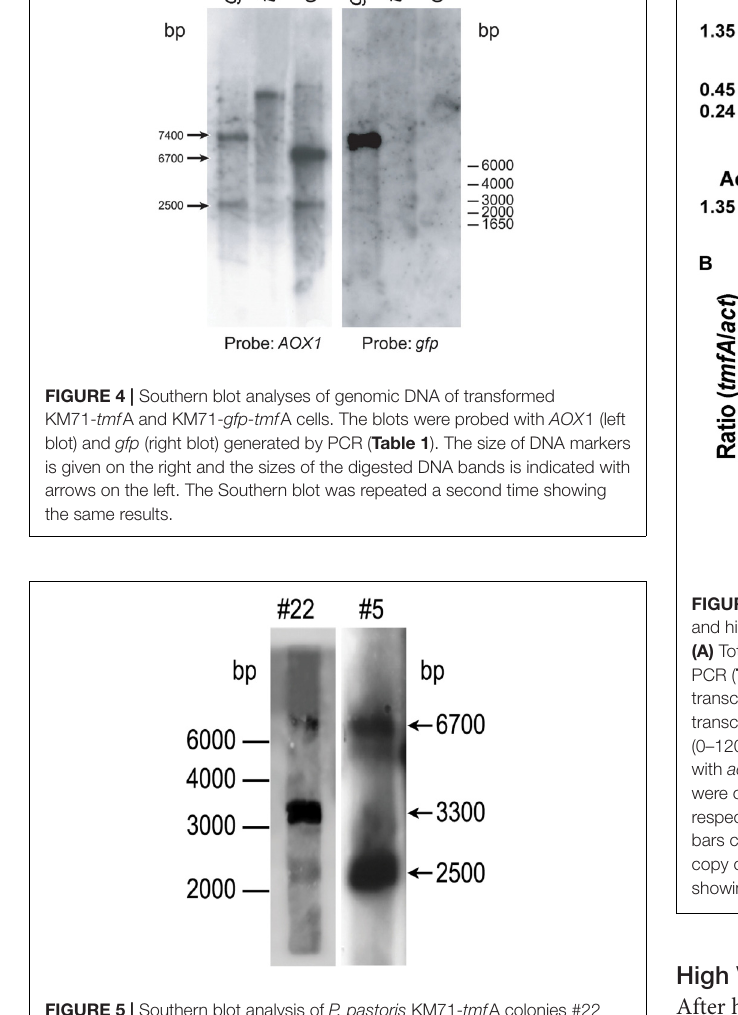
FIGURE 5 | Southern blot analysis of P. pastoris KM71- tmf A colonies #22 and #5. DNA was extracted and digested with Eco RI and analyzed by Southern blotting using aox 1 probe. The size of the DNA markers is on the left and the sizes of the digested DNA bands is indicated with arrows on the right. The Southern blot was repeated a second time showing the same results.